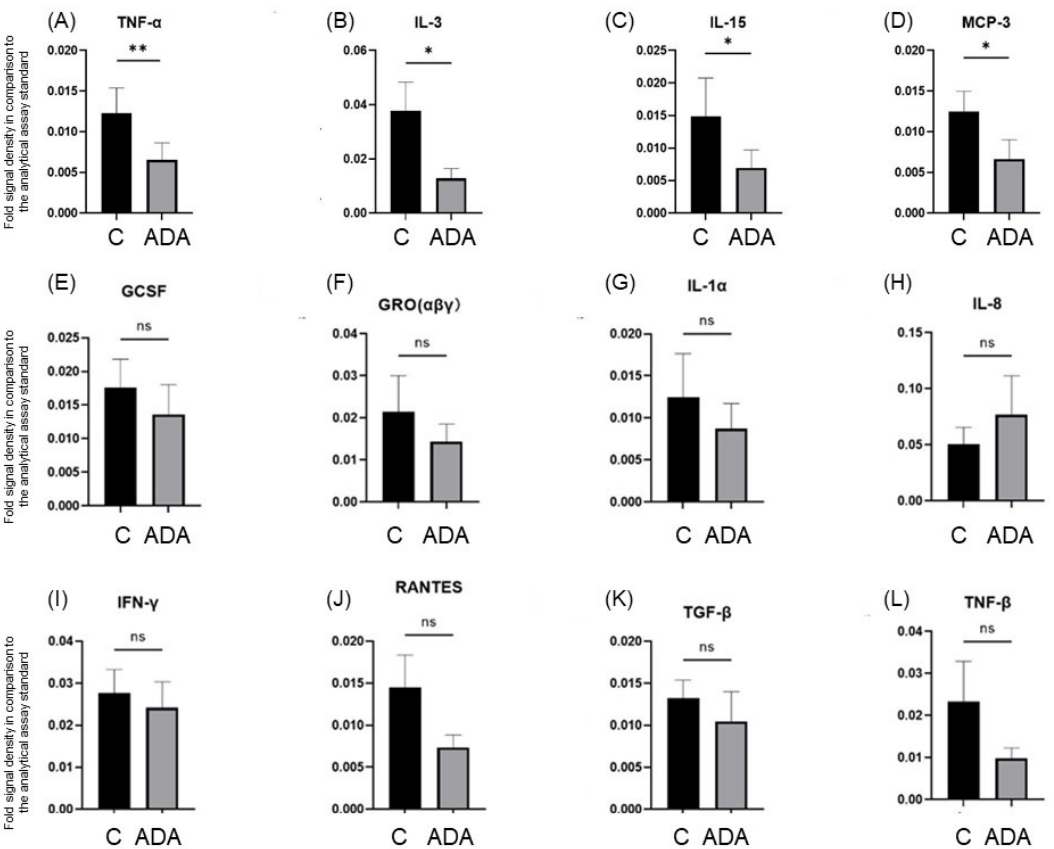
Figure 3. Comparative expression of levels of TNF- α ( A ), IL-3 ( B ), IL-15 ( C ), MCP-3 ( D ), GCSF ( E ), GRO ( αβγ ) ( F ), IL-1 α ( G ), IL-8 ( H ), IFN- γ ( I ), RANTES ( J ), TGF- β ( K ), and TNF- β ( L ) in HS lesional skin of the control group (C) and the adalimumab-treated group (ADA) maintained for 3 days in the HS 3D-SeboSkin model. Comparisons were performed against the analytical assay standard. ** = p < 0.01, * = p < 0.05, ns = not significant.